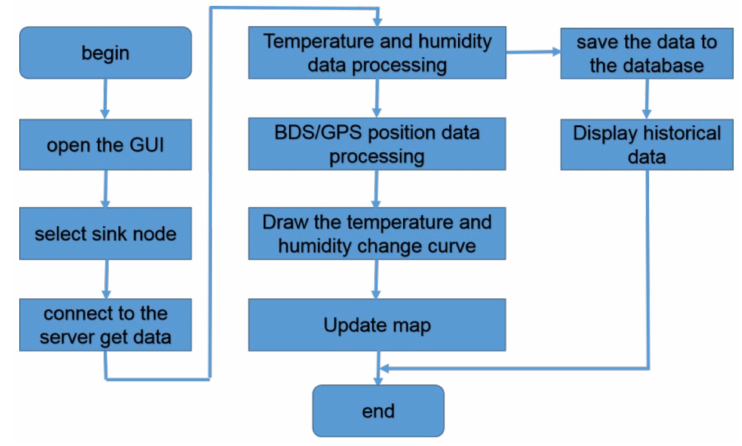
Figure 10. The operation flowchart of monitoring center.